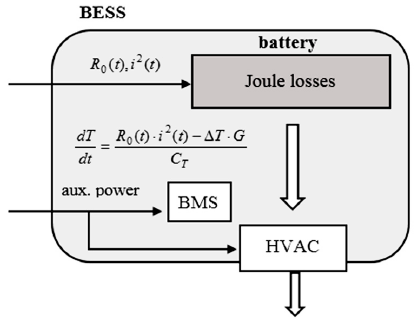
Figure 6. Thermal (white arrows) and electrical (black arrows) power flows associated to the BESS electrical-thermal model.